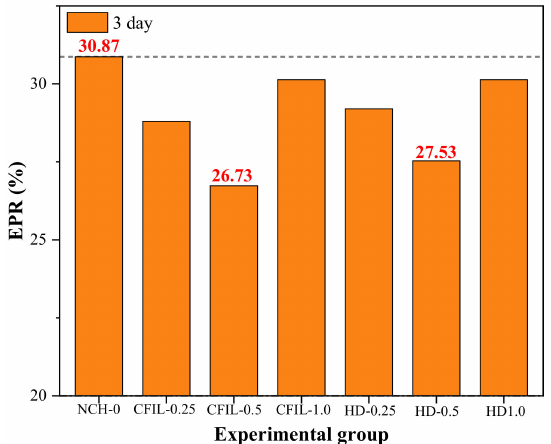
Figure 17. Early permeant ratio (EPR) in each experimental group.